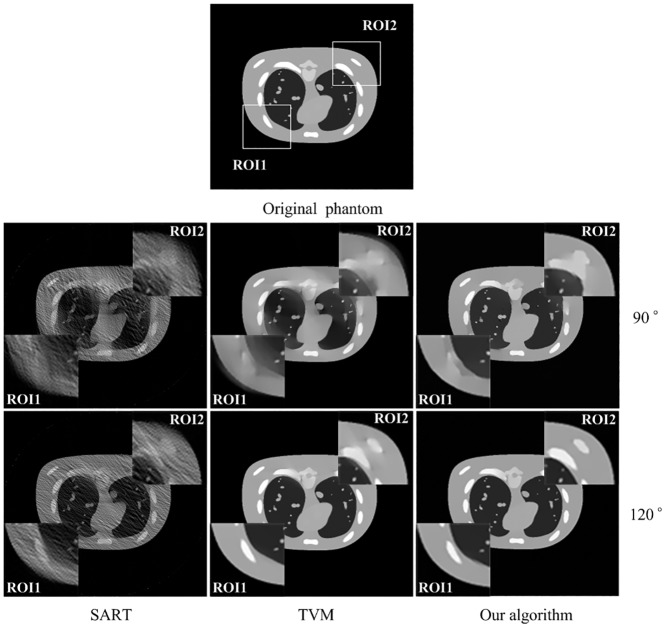
The tomographic results of NCAT phantom from noisy projection dataset.The image on the top is the original phantom. The following rows are the results reconstructed from scanning angular ranges [0, 90°] and [0, 120°], respectively. Images from left to right in each row present the results reconstructed by SART algorithm, TVM algorithm and our algorithm, respectively. The gray scale window is set to [0, 1.0].